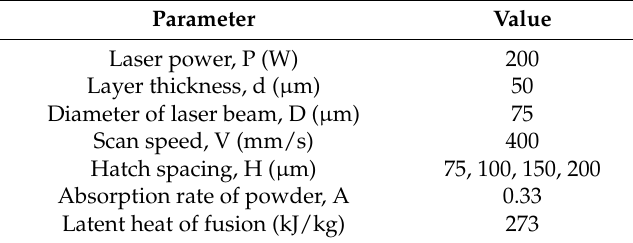
Figure 1. Schematic of the SLM process: ( a ) Physical model of SLM and ( b ) the scanning strategy. Table 1. Properties of the material (316L SS) and SLM processing conditions.